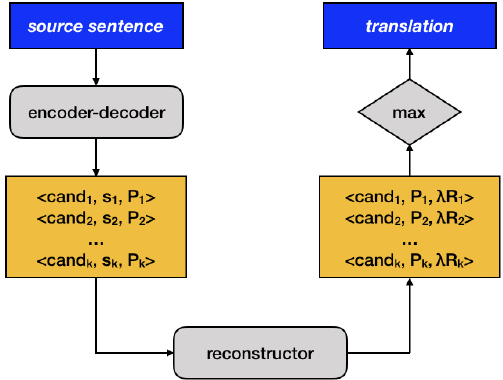
Figure 7. Illustration of decoding with reconstruction.